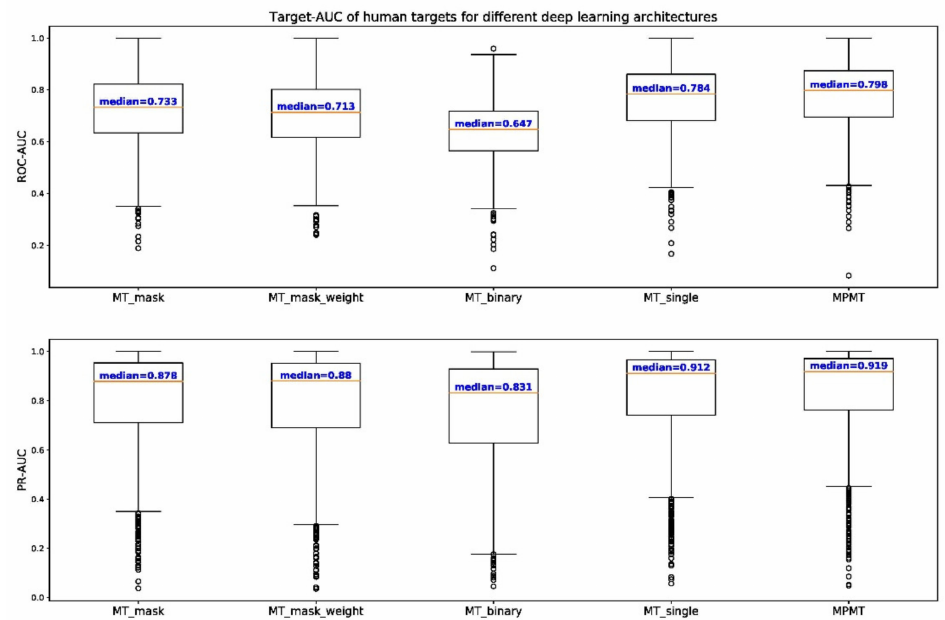
Figure 5. Box plot of target-AUC of different deep learning architectures for 1067 human targets. The upper graph shows the distribution of target-AUC for ROC while the graph below shows the distribution for precision-recall (PR) curve indicated as PR-AUC. The median target-AUC is represented as a red line and outliers outside the fences (1.5 times the interquartile range) are indicated as small